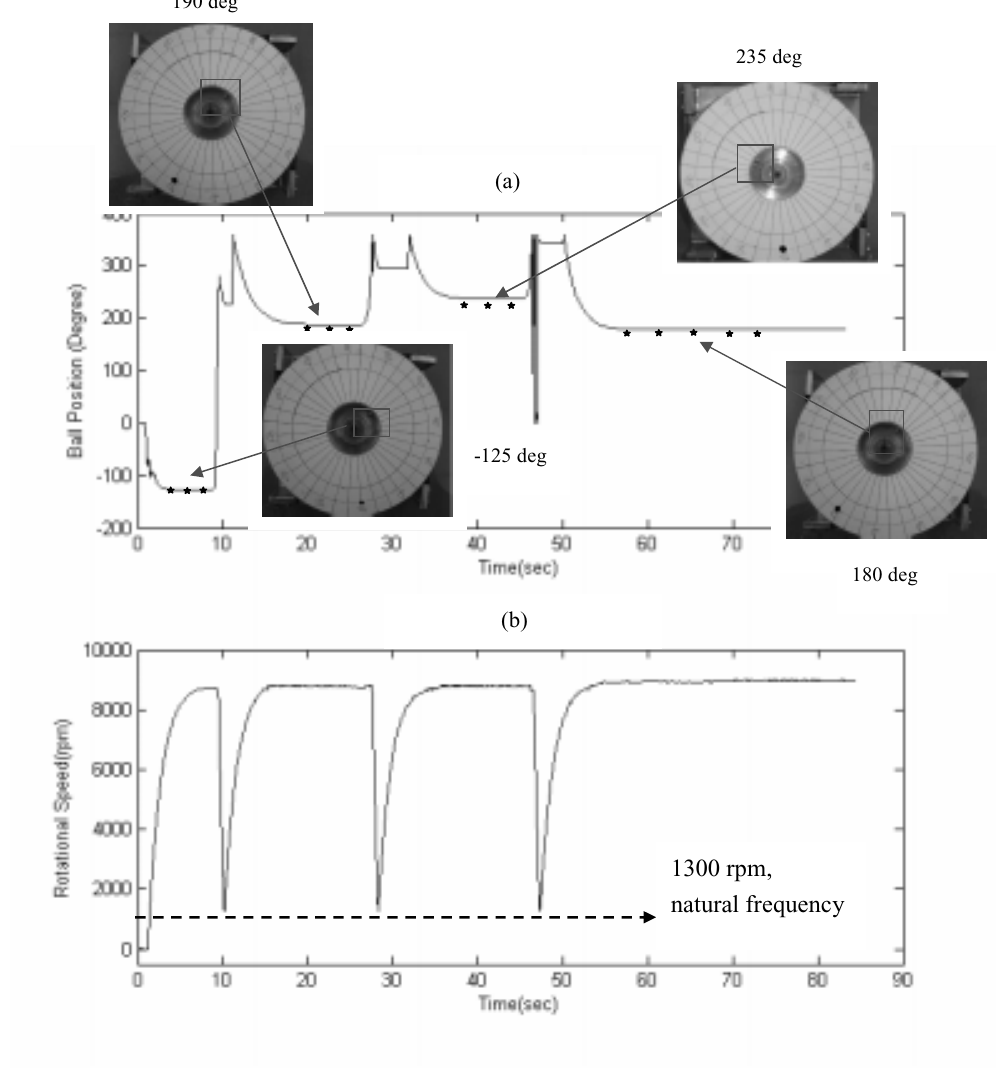
Fig. 17. Experimental results by the ball re-positioning scheme with operation speed 9000 rpm, experiencing three trials of speed drops. (a) Ball position versus time and the corresponding pictures, where the solid line, “–”, represents the observed results and the stars, “*”, denotes the actual ball positions. (b) The rotating speed of spindle motor versus